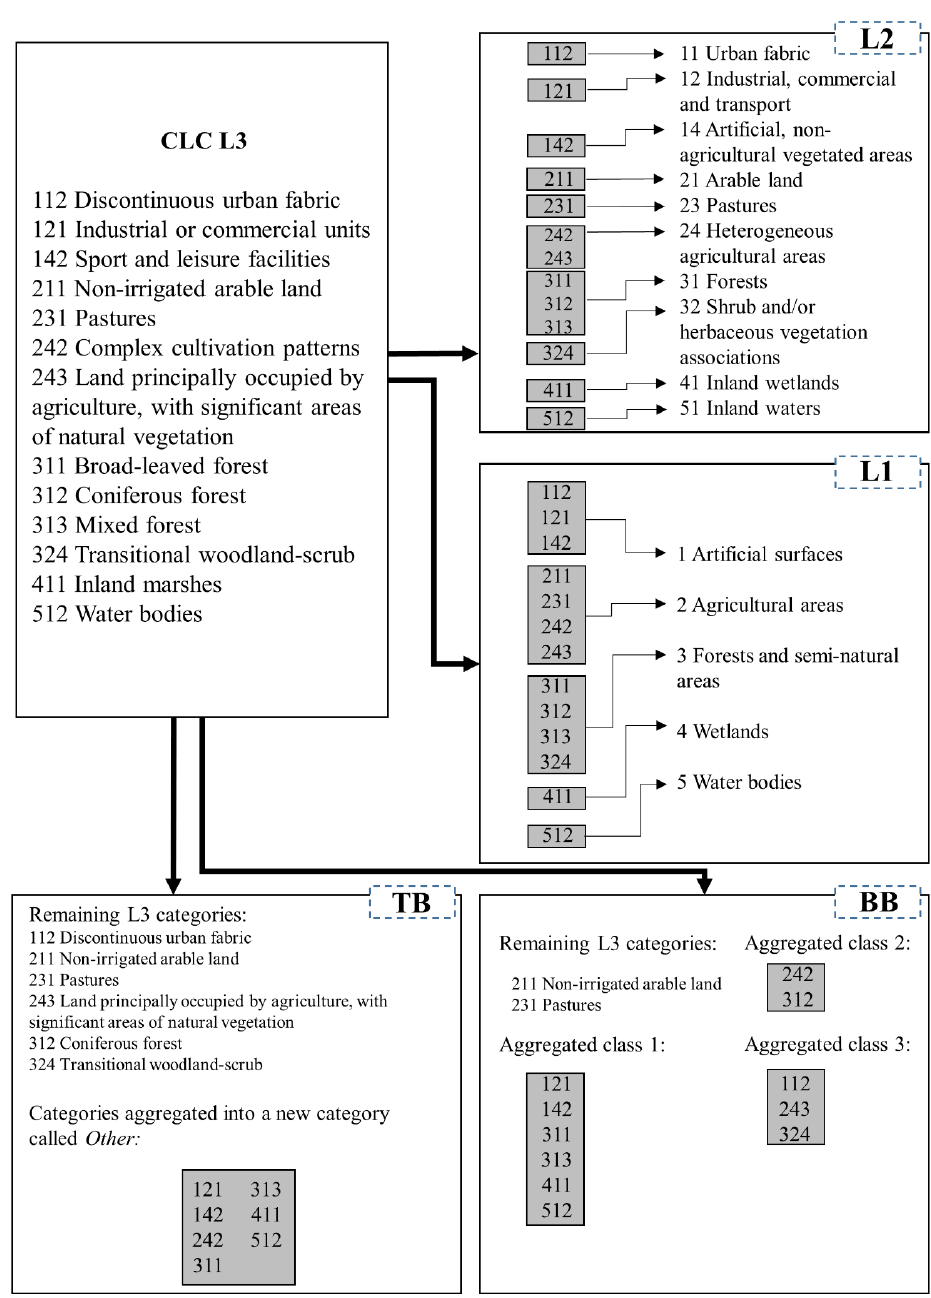
Figure 2. An example of category aggregation of CLC Level 3 categories according to the category aggregation schemes used in this research, based on study extent Borovany, Zoom level L (CLC L3 = categories according to CLC Level 3; L2 = categories according to CLC Level 2; L1 = categories according to CLC Level 1; BB = categories according to behavior-based category aggregation; TB = categories according to threshold-based category aggregation).